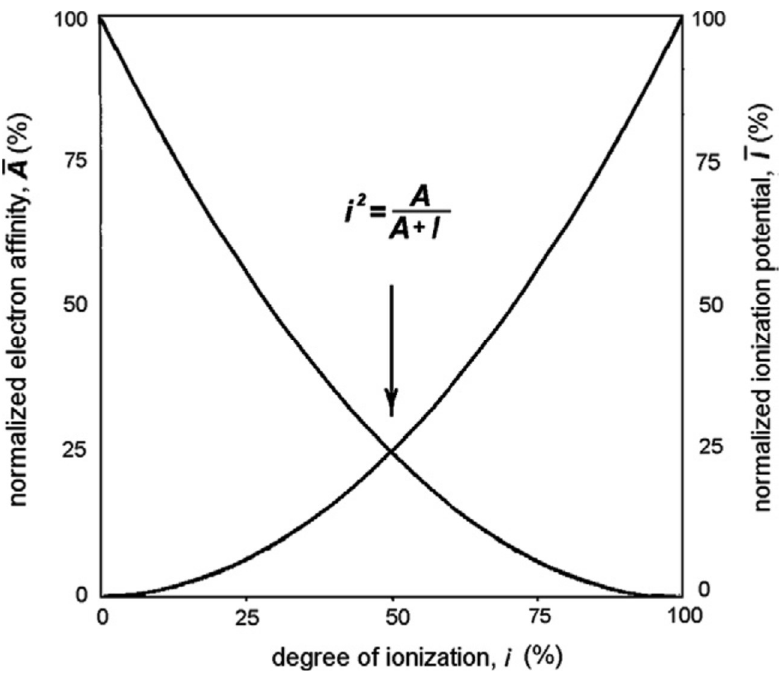
Figure 2. Schematic presentation of I and A as functions of i ; the curves correspond to Equation (15).